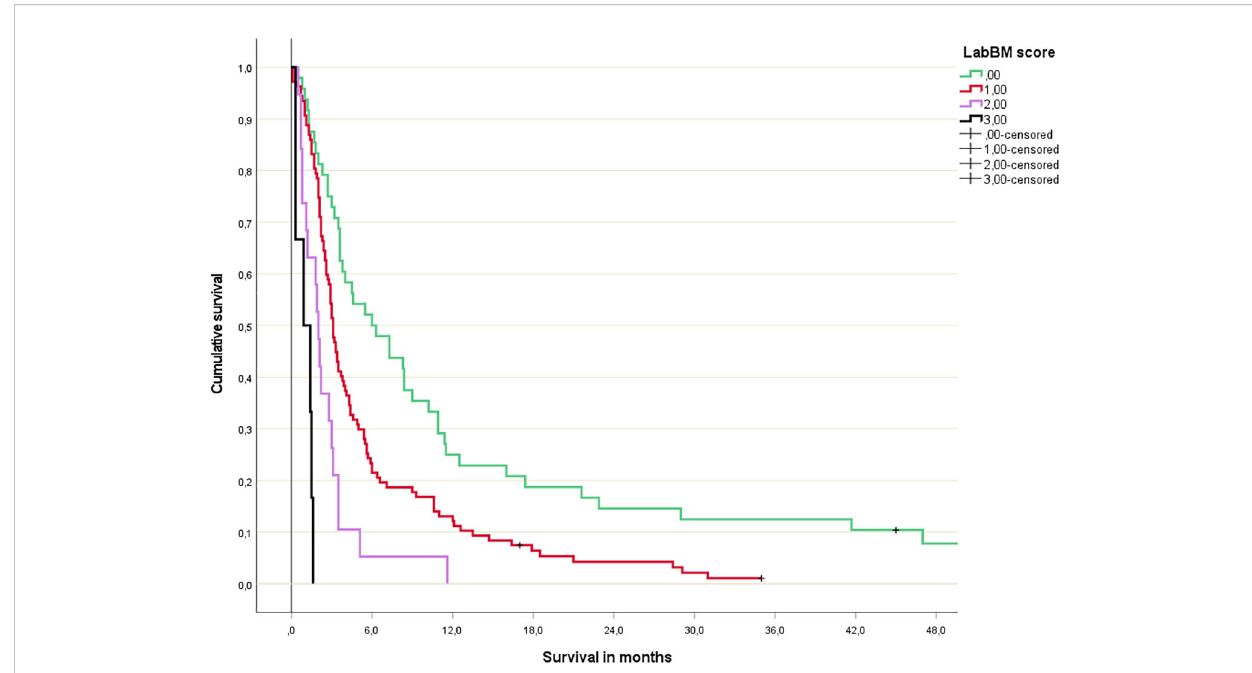
FIGURE 4 Modi fi ed LabBM score 4-tiered survival prediction (Kaplan-Meier analysis; for further details please see Table 3; p=0.01 or better for all